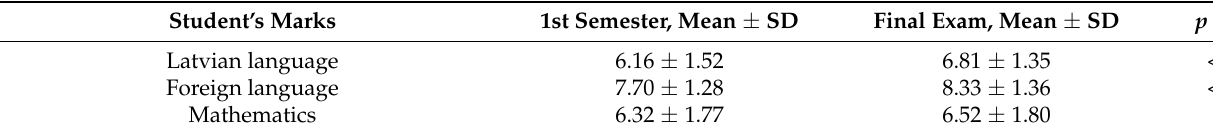
Table 1. Descriptive statistics of students’ marks, anxiety level, and QOL, by time point.